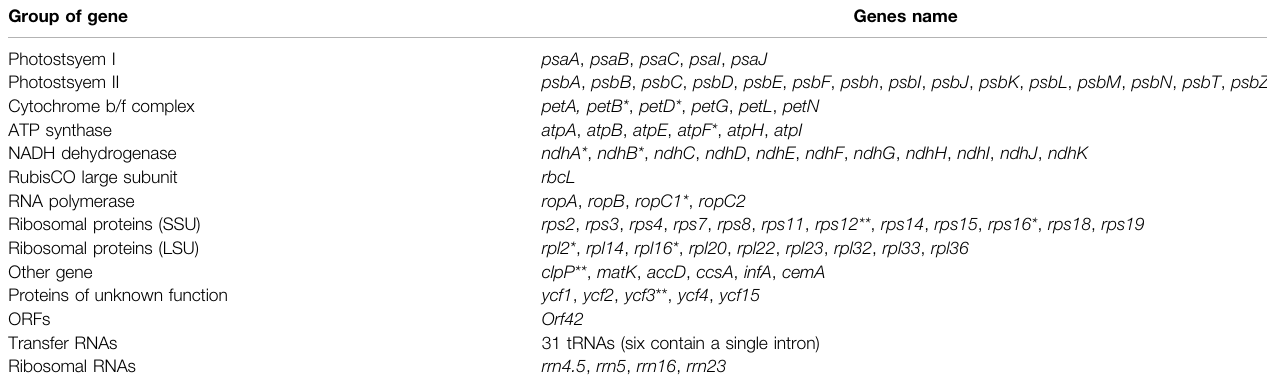
TABLE 2 | Genes present in the Acer chloroplast